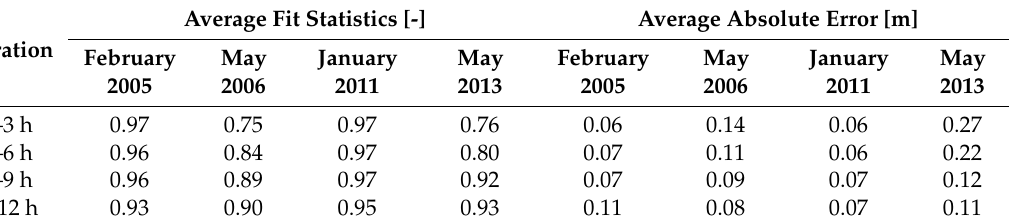
Table 4. Average Fit Statistics and absolute error for the four events at the end of the forecast update interval of three hours.